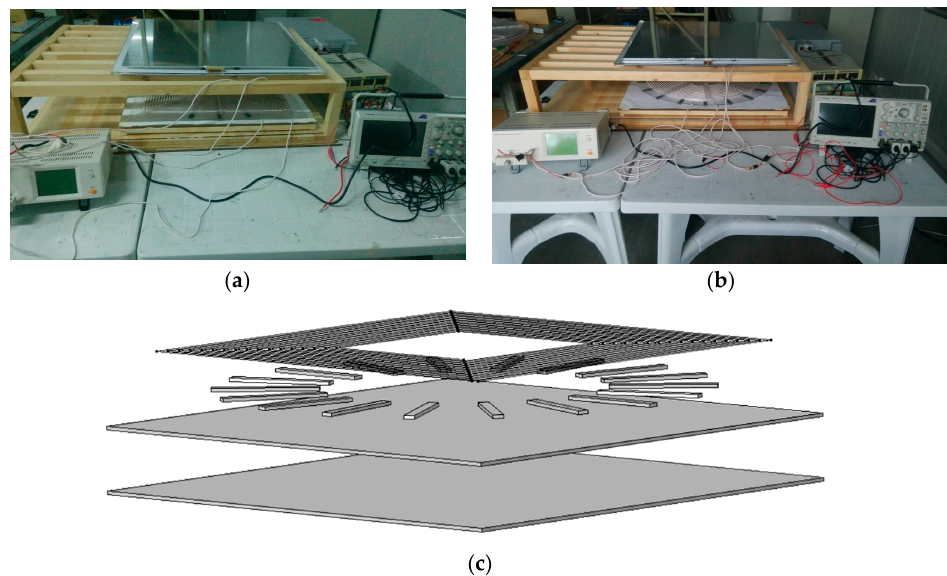
Figure 6. ( a ) Experimental mock-up of circular coils. ( b ) Experimental mock-up of square coils. ( c ) Basic structure of a pad.